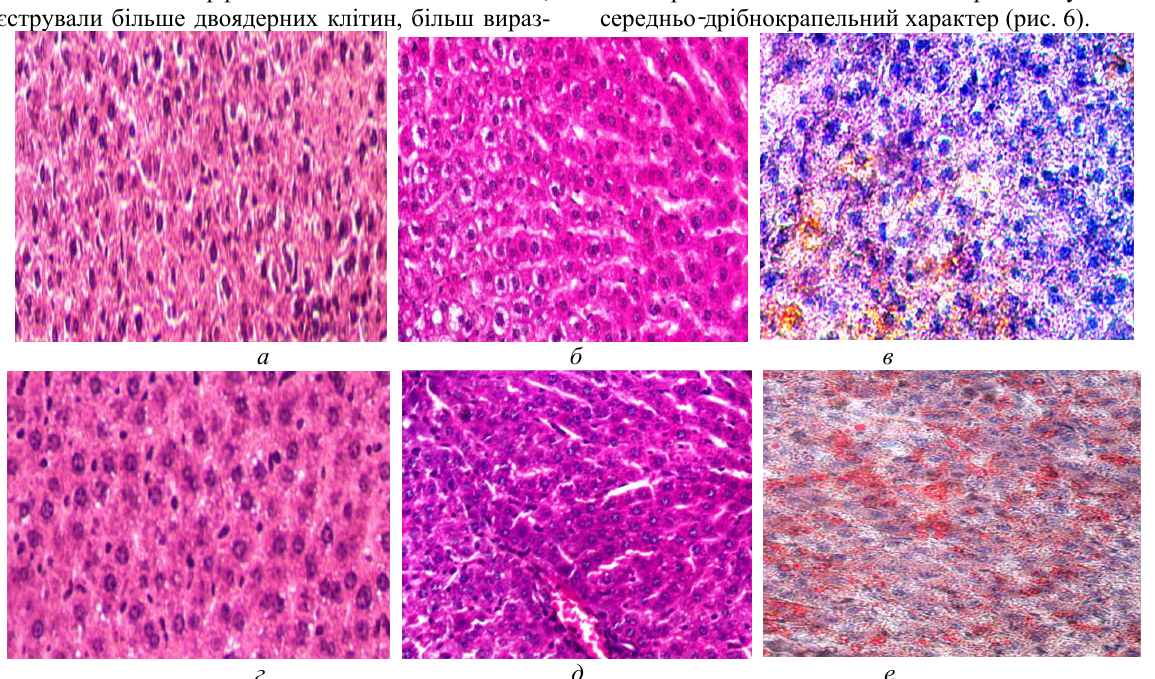
Рис. 6. Печінка щурів, які отримували збір «Арфазетин»:у дозі 9 мл/кг: а, г – коливання у гістологічному стані паренхіми (а – ×200, а – ×250). Гематоксилін-еозин; б, д – вмісту глікогену в цитоплазмі (×200). гепатоцитів 1 ШІК-реакція; в, е – вміст жиру в цитоплазмі гепатоцитів (в – ×250, е – ×200). Судан